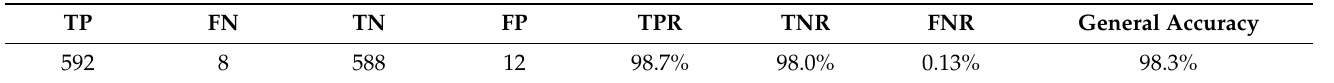
Table 5. The performance of the DCN_Fire model on the test data set.